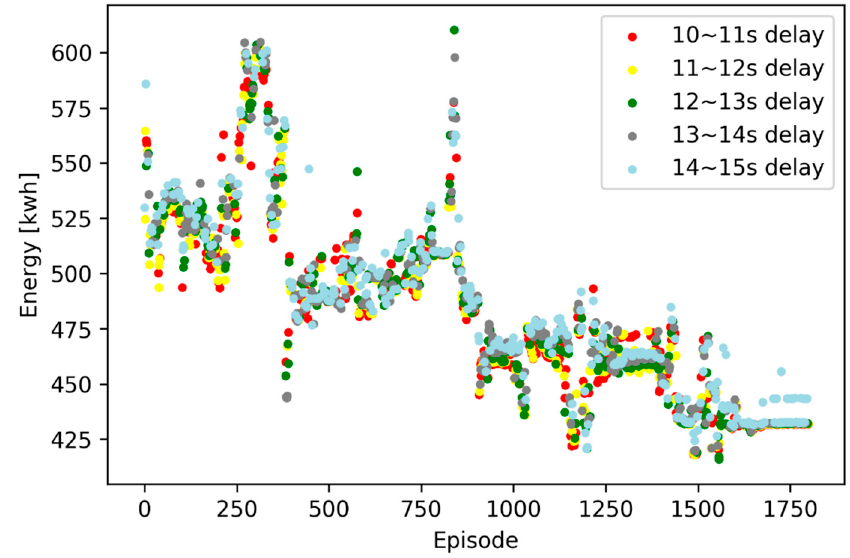
Figure 13. Energy consumption during the training process under continuously sampling random disturbances in the three-train network.